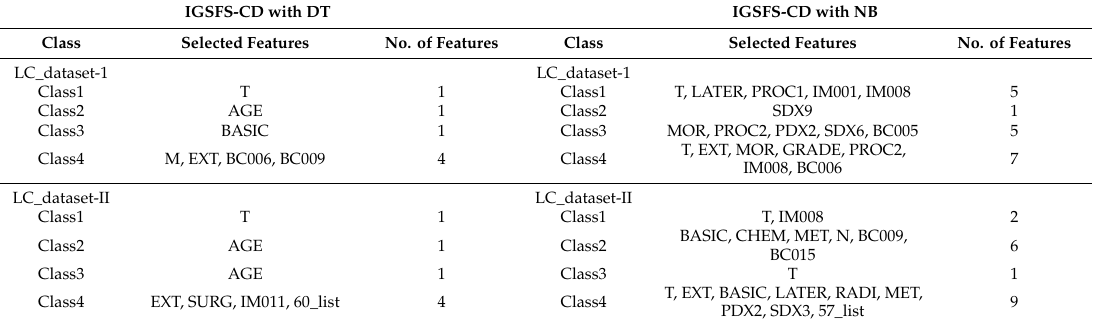
Table 10. The number of selected features in each class using the IGSFS-CD method with two datasets. IGSFS-CD with DT IGSFS-CD with